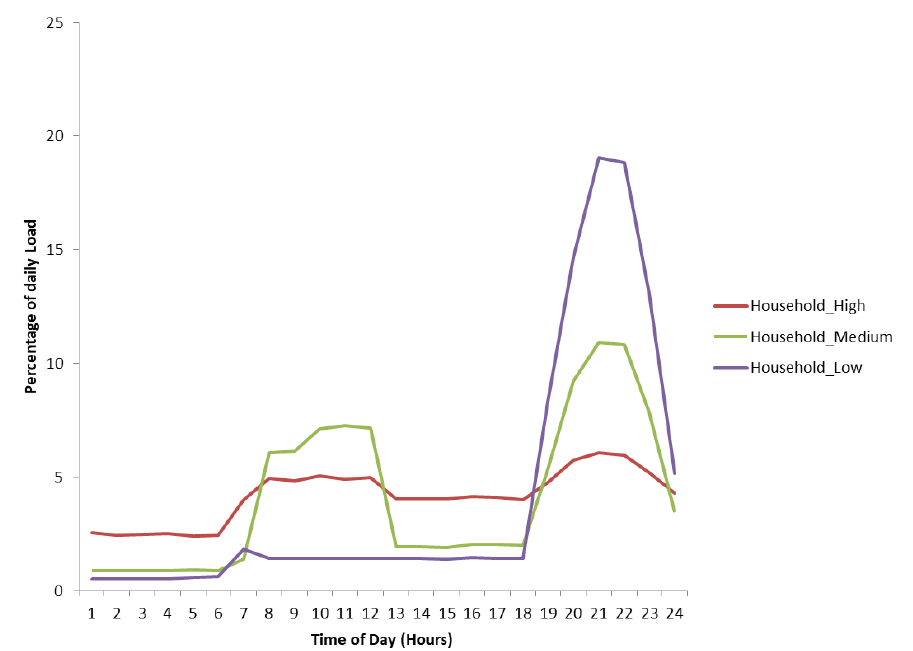
Figure 8. Load profile for household category.